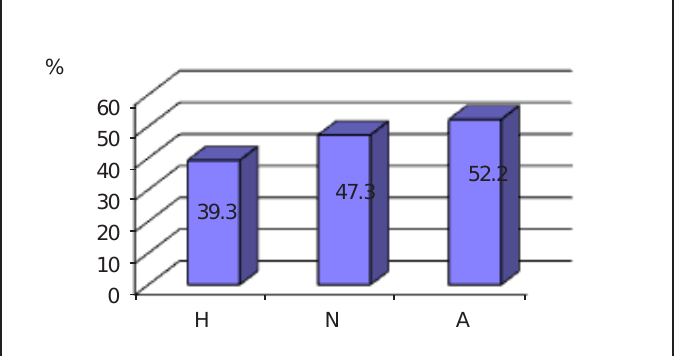
Fig. 4. The strength index of the right hand in students of different somatotypes: H – hypersthenics; S – sthenics; A –